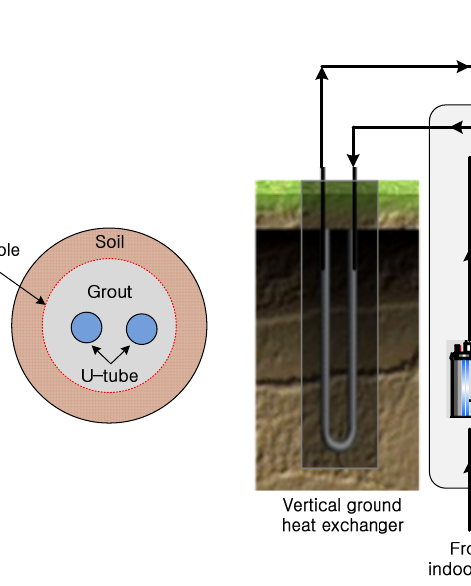
Figure 2. Schematic of a ground source heat pump